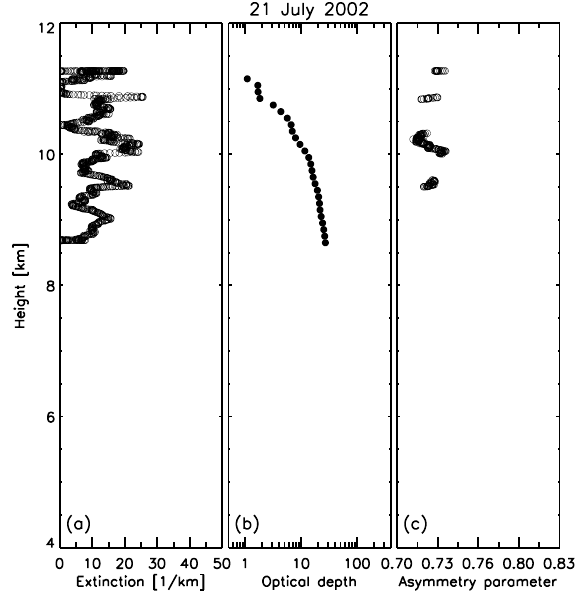
Fig. 11. Same as Fig. 7 but for 21